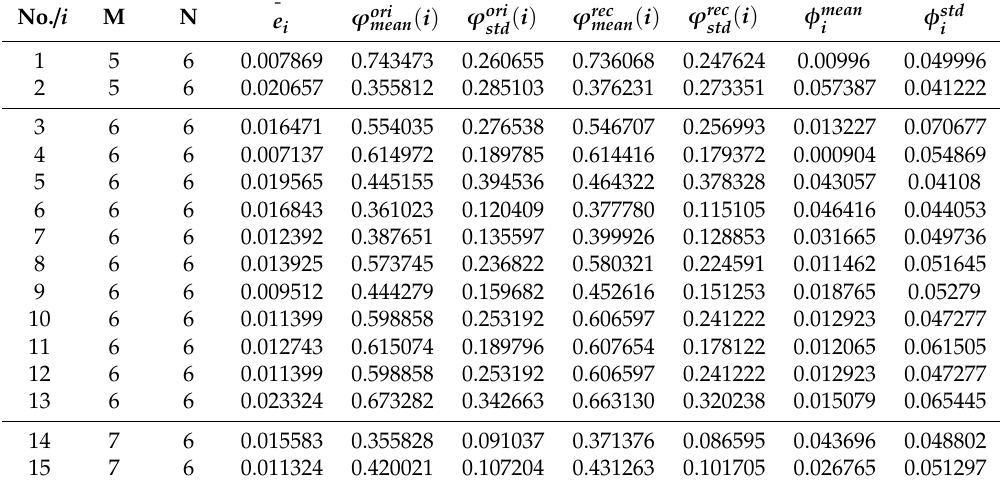
Table 1. The comparison of the wavelet reconstruction e ff ects under di ff erent M and N combination. No. /